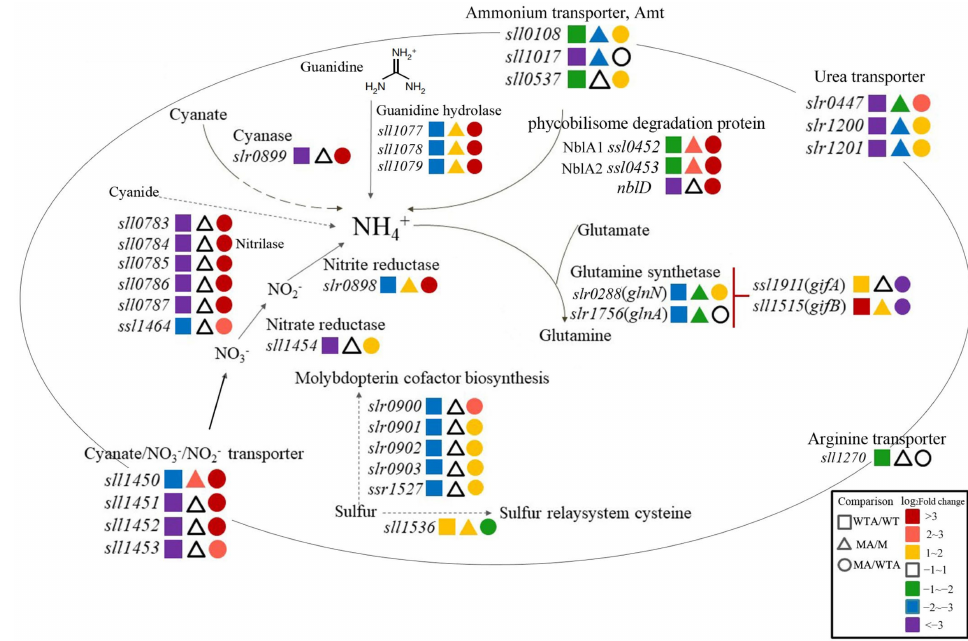
Figure 4. Comparison of transcript abundance of genes involved in nitrogen uptake and ammonium assimilation. Differential expressed key enzymes and transporters are included and presented as their gene symbol. The comparison pair and fold changes are indicated in different shapes and colors respectively. WT and WTA are wild type without and with NH 4+ stress. M and MA are ∆ slr1821 knockout mutant without and with NH 4+